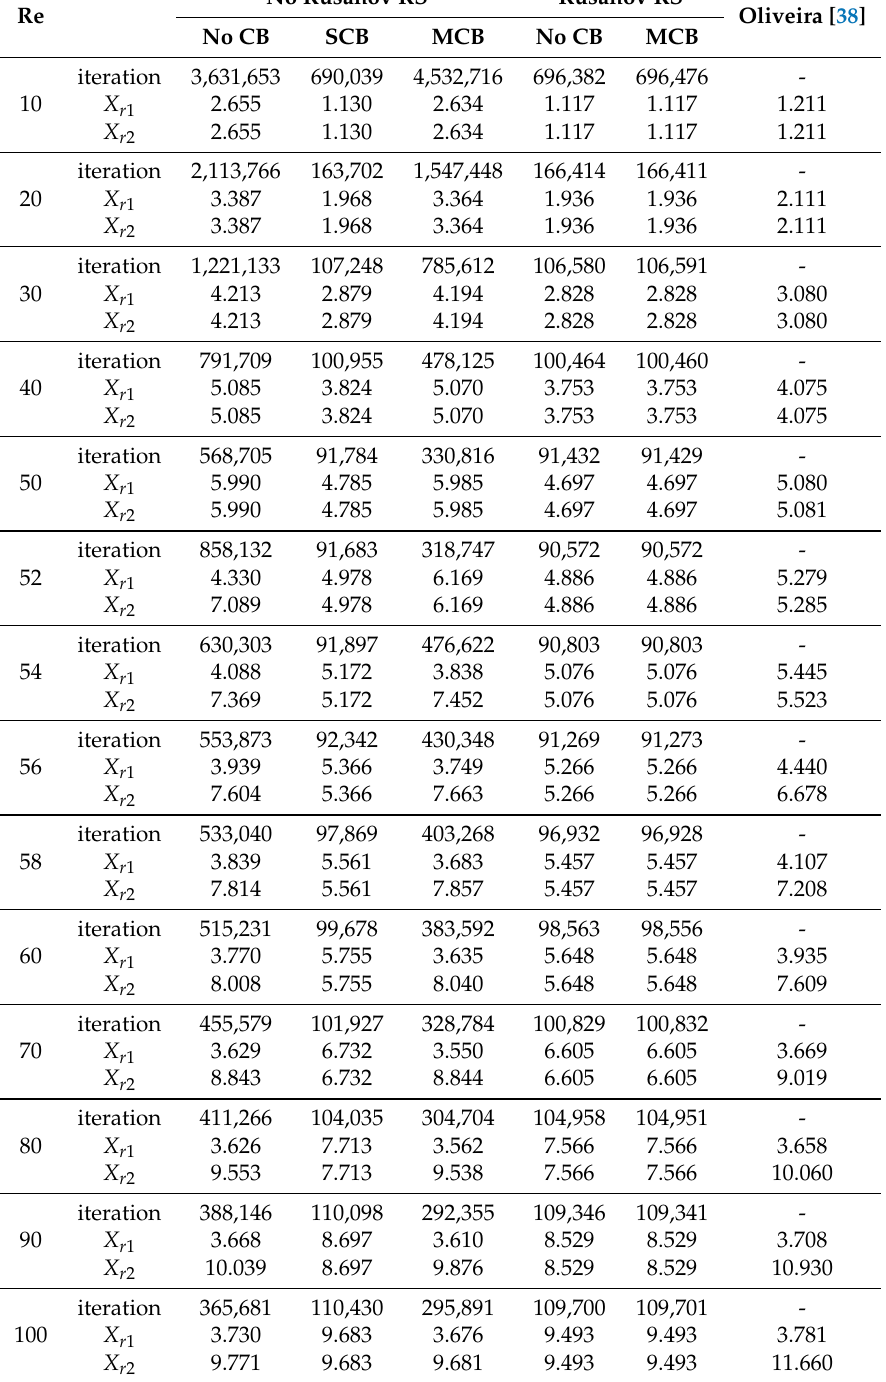
Table 5. Prediction of the reattachment length X r 1 and X r 2 and number of iterations required for convergence for different Reynolds numbers using the AC method for various combinations of CB schemes and the Rusanov Riemann